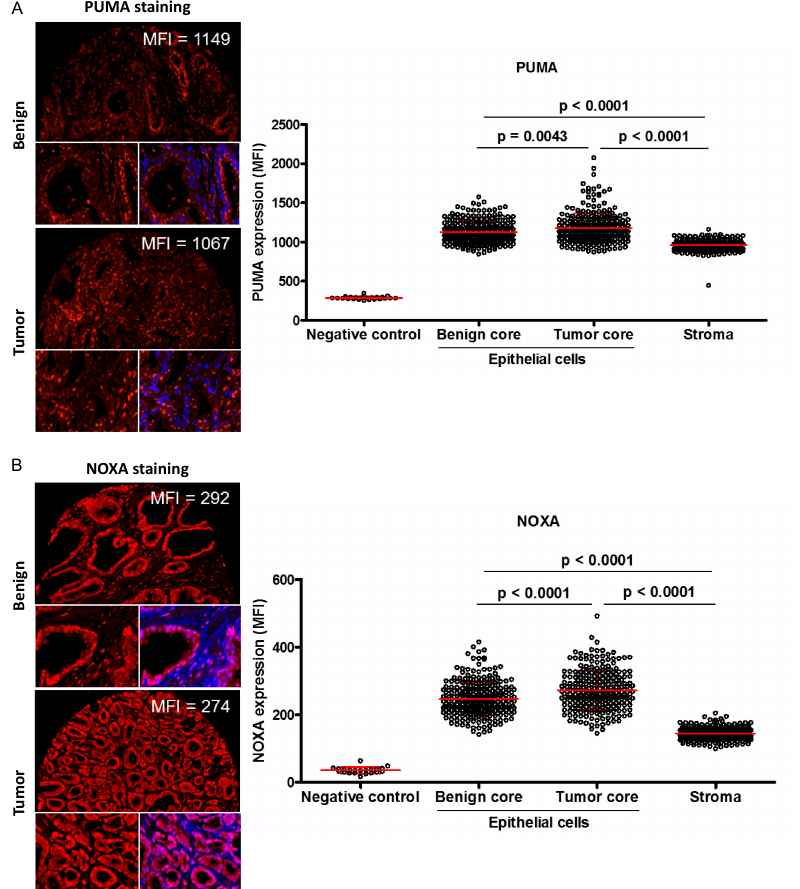
Figure 2. Compartment distribution of PUMA and NOXA expression in the prostate cancer (PC) patient cores. ( A ) Illustration of staining intensities (MFI) quantified by VisiomorphDP software was shown for moderate PUMA expression in one representative core of benign or tumor tissue. ( B ) Illustration of staining intensities (MFI) quantified by VisiomorphDP software is shown for moderate NOXA expression in one representative core of benign or tumor tissue. For each patient, expression levels were calculated using the average mean of two cores. Moderate staining was close to the median MFI intensity. Negative controls correspond to the quantification of MFI in cores when IF was performed with only secondary antibodies. Biomarker of interest (red), nuclei (blue) and merge (DAPI + marker) (purple).